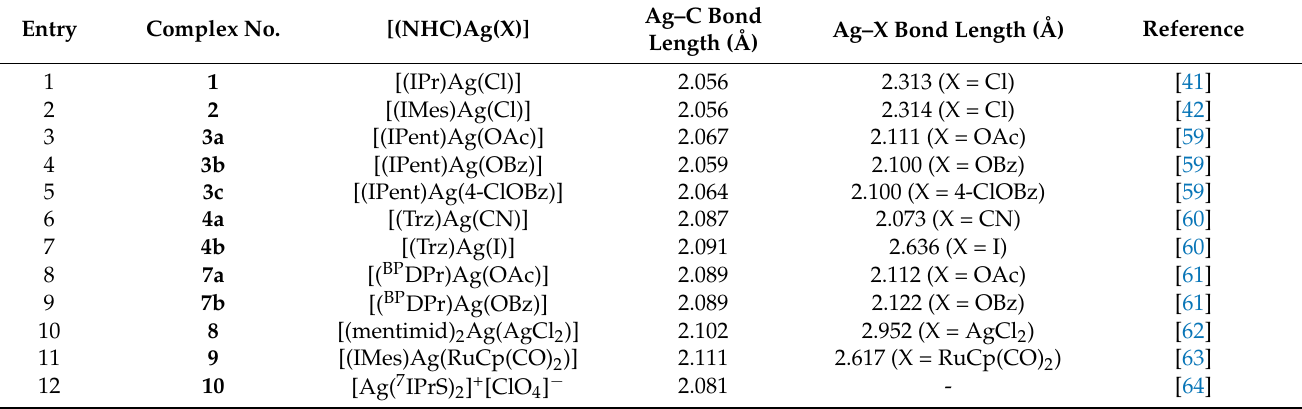
Table 1. Ag–C (carbene) bond lengths of the most common Ag–NHC complexes used in the π - functionalization of alkynes. Ag–X bond lengths are shown for